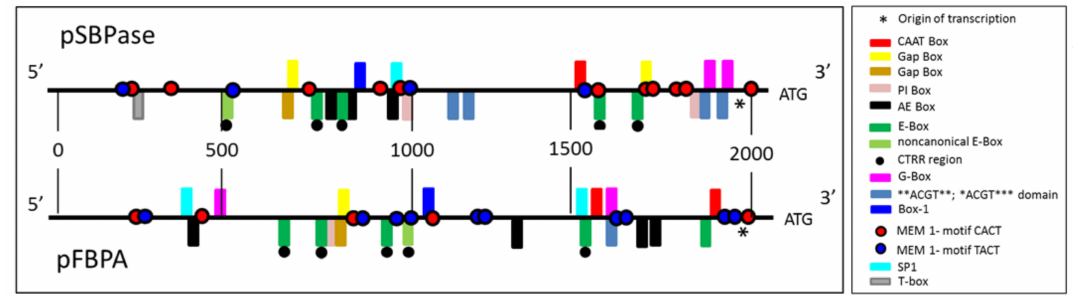
Figure 1. Schematic representation of a two-kilobase upstream region of the sedoheptulose-1, 7-bisphosphatase (SBPase) and fructose-1,6-bisphosphate (FBPA) genes from B. distachyon showing potential regulatory motifs. ATG denotes the codon initiating translation of the SBPase and FBPA proteins.